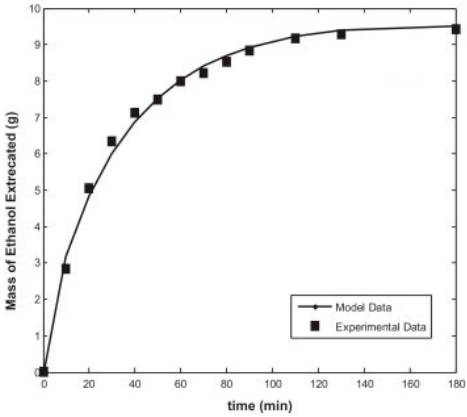
Figure 17. Comparison of experimental extraction profile of a silica alcogel to model data at 100 bar, 40 °C [5].